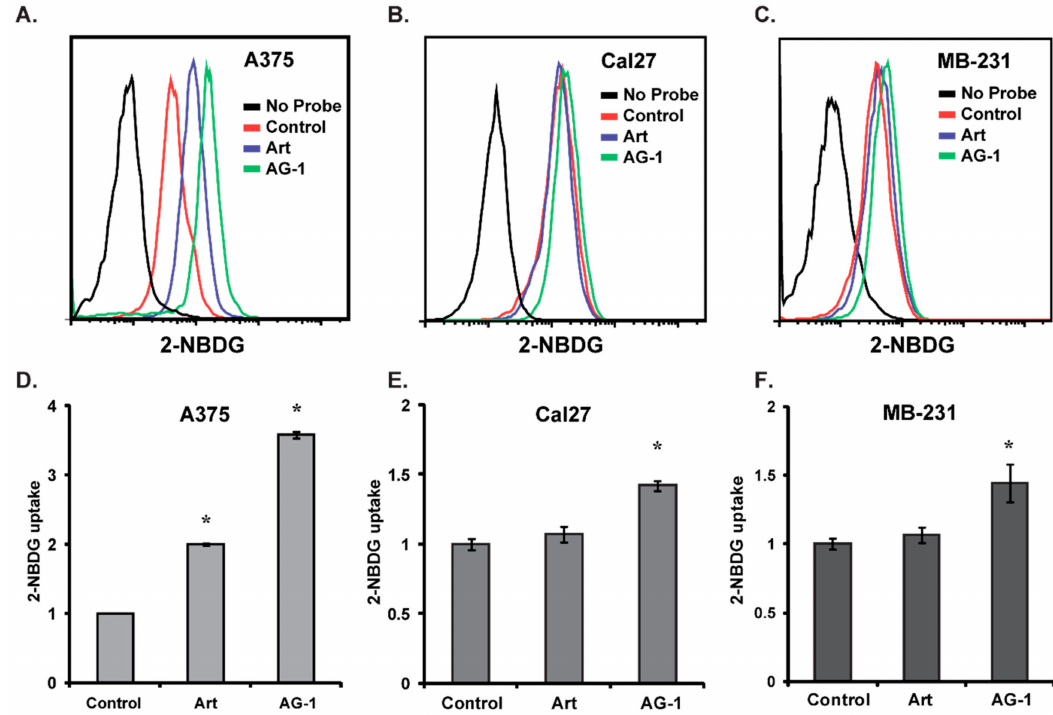
Figure 8. Higher glucose uptake in artemisinin dimer (AG-1)-treated human cancer cells. Asynchronous cultures of ( A,D ) A375 melanoma, ( B,E ) Cal27 head–neck and ( C,F ) MB-231 breast cancer cells were treated with 100 µ M Art or AG-1 for 24 hours. Cells were rinsed and incubated with DMEM (Dulbecco’s Modified Eagles Media) containing 20 µ M of 2-NBDG (2-( N -(7-nitrobenz-2-oxa-1,3-diazol-4-yl)amino)-2-deoxyglucose) for 1 hour. 2-NBDG fluorescence was measured using flow cytometry. ( A–C ) show representative flow cytometry histograms and quantitative data are shown in ( D–F ). Asterisks represent significance compared to untreated control cells; n = 3, p <